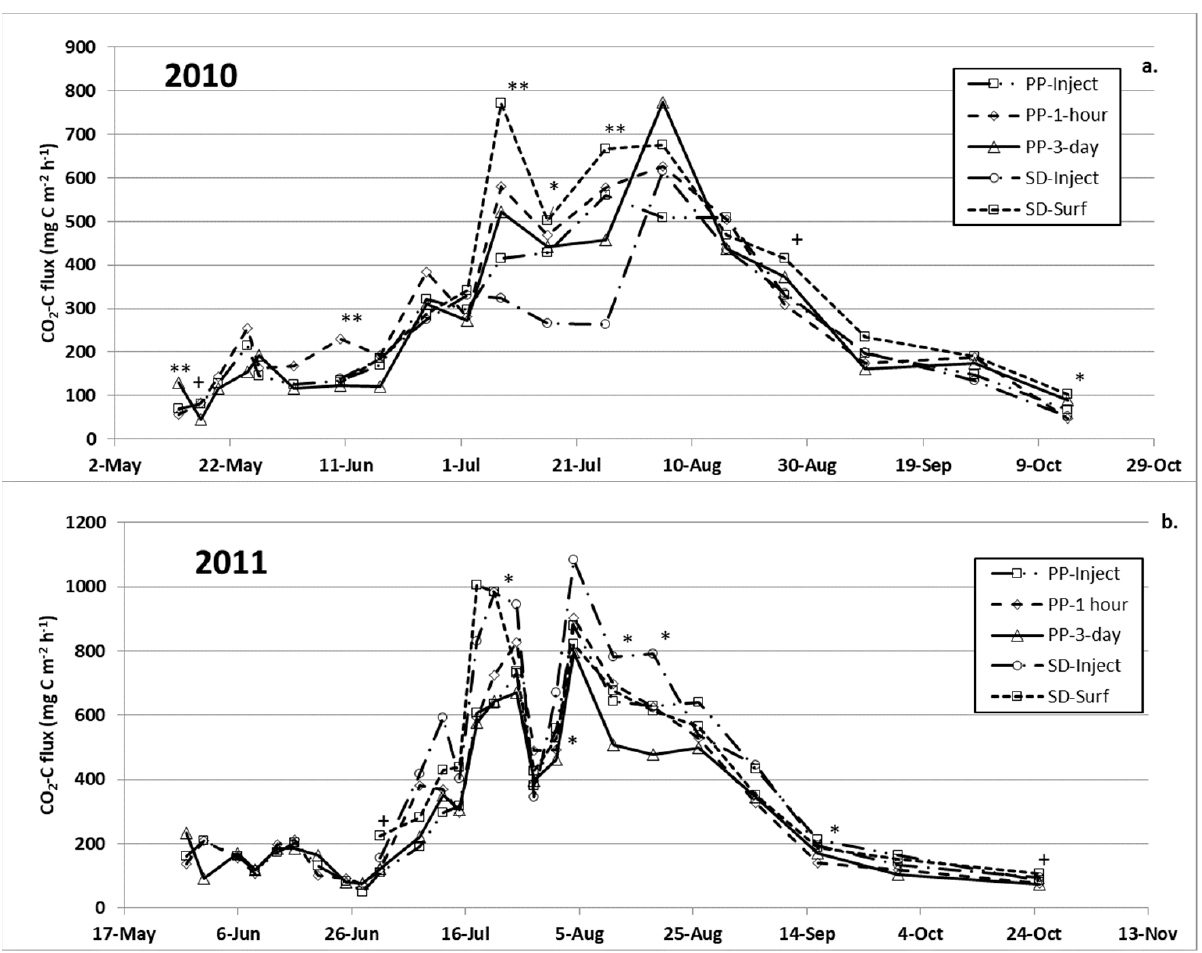
Figure 5. Carbon dioxide (CO 2 -C) fluxes (mg m − 2 h − 1 ) for 2010 ( a ) and 2011 ( b ). Means differing among treatments within a sampling date are denoted as follows: ** p = 0.01; * p = 0.05; + p =